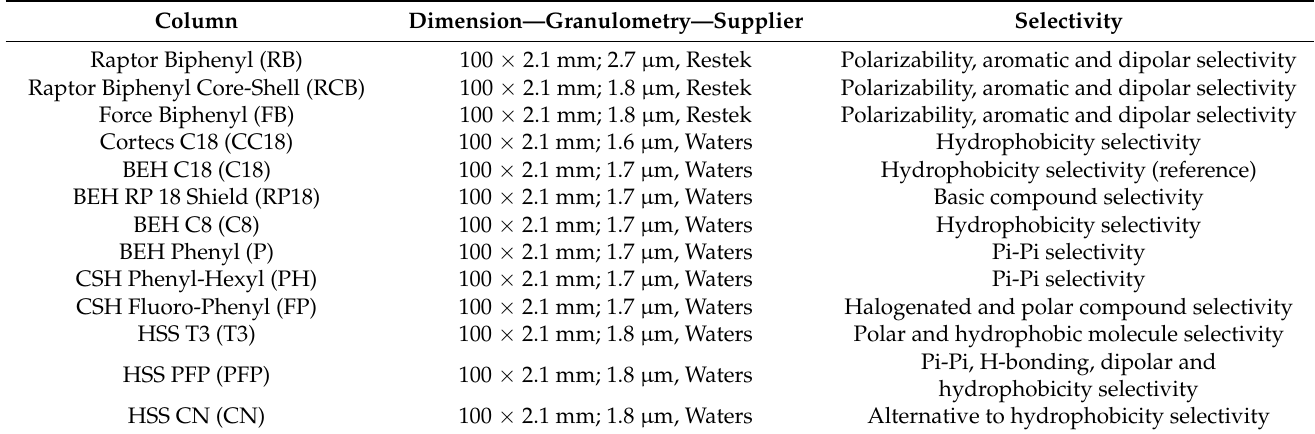
Table 5. Analytical columns used for determining the chromatographic descriptors with their abbreviation, dimension, and selectivity